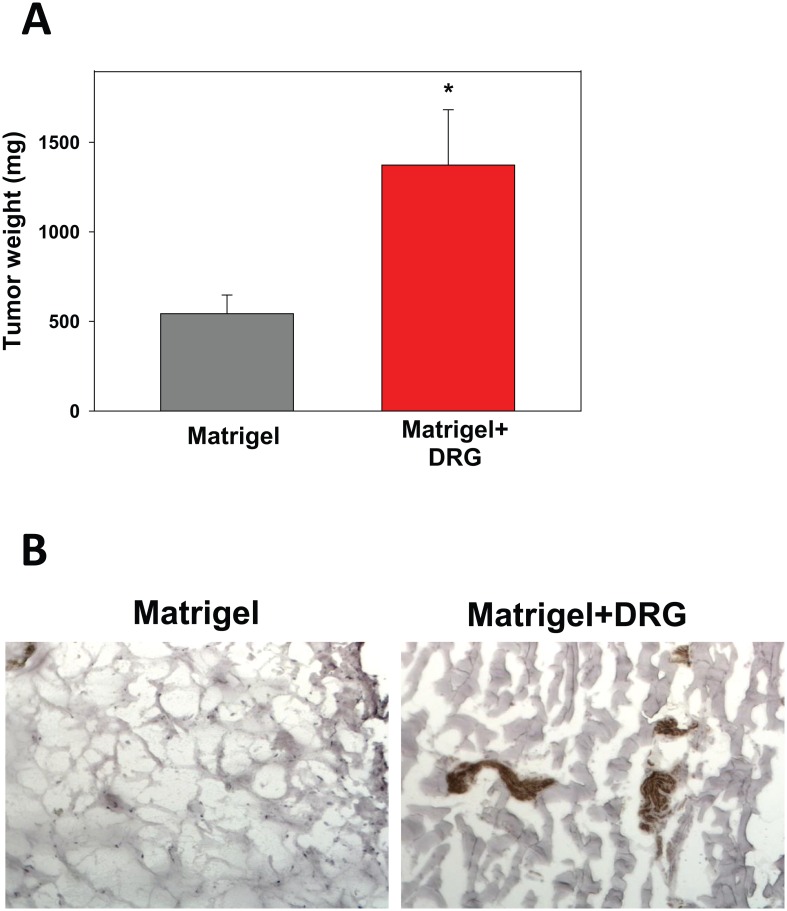
Pre-existence of DRG neurons within the Matrigel increased B16 melanoma growth in the Matrigel in mice.C57BL/6 mice (5 mice/group) received s.c. injection of control Matrigel (500μl ECM gel diluted 1:1 in RPMI 1640) and Matrigel with cultured DRG neurons (1x104 cells). B16 cells (5x104/300μl PBS) were administered into the Matrigel plaques two weeks later. Animals were sacrificed two weeks post tumor inoculation, and Matrigel plaques were weighted to characterize tumor growth (A). 50x103 tumor cells alone or mixed with cultured DRG neurons (1:5 cell:cell ratio). (A). The presence of live DRG neurons in the Matrigel harvested two weeks after administration, i.e., right before the tumor cell injection, was determined by immunohistochemistry with anti-Neurofilament H antibody as described in Materials and Methods (B). Left panel show control Matrigel, right panel show Matrigel with added DRG neurons two weeks after injections. Matrigel weight is expressed as the mean ± SEM. *, p<0.05 (ANOVA, n = 3).